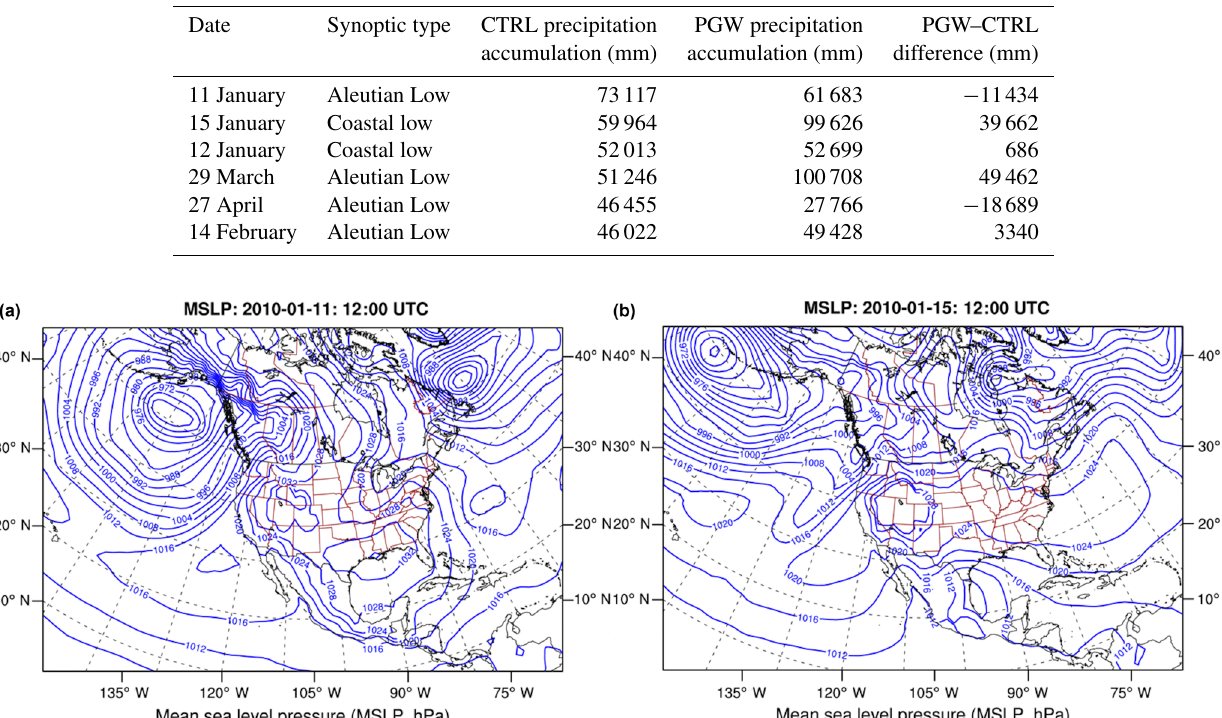
Figure 12. Mean sea-level pressure using data from the JRA-55 (Kobayashi et al., 2015) to characterize synoptic patterns. Panel (a) is an example of an Aleutian Low occurring on 11 January 00:00UTC, and panel (b) is an example of a coastal low occurring on 15 January 12:00UTC. These atmospheric rivers reached into the eastern sub-area for all of the extreme days, with the exception of 14 February. Under PGW, these five atmospheric rivers extended even farther east and with higher water vapour